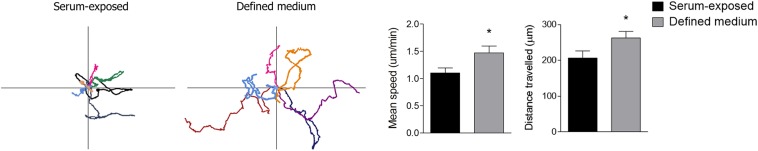
Microglial surveillant capacity is increased when cultured in defined medium. Representative trajectories of single cells (left) are represented as differentially colored lines. The point of intersection of the axes constitute the initial position of the cells. The histogram (right) represent the mean speed of their movement. Both parameters were acquired using the Kinovea software. The time-lapse video (3 h, one frame per minute) was obtained using a Nikon Biostation IM-Q microscope. Data shows mean ± s.e.m. from at least 20 cells/experiment, n = 3 independent experiments. * p < 0.05, Student’s t-test.